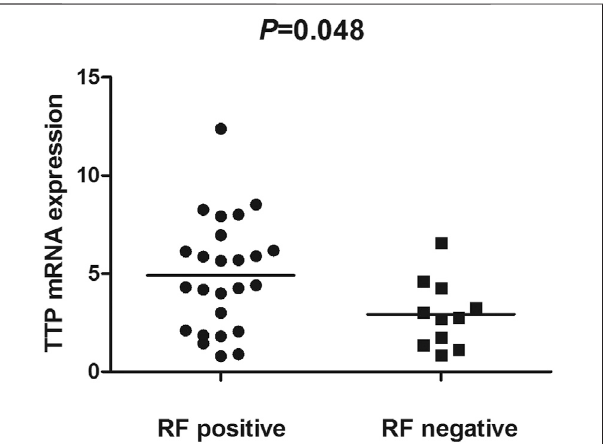
FIGURE 2 | Comparision of TTP mRNA expression level in PBMCs between RA patients and normal controls. FIGURE 3 | Comparision of TTP mRNA expression level in PBMCs between RF-positive RA patients and RF-negative RA